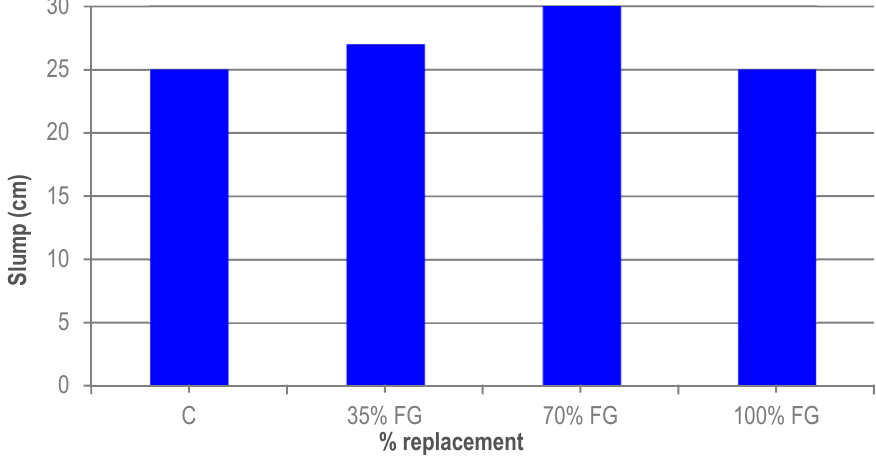
Figure 3. Slump of UHPC .